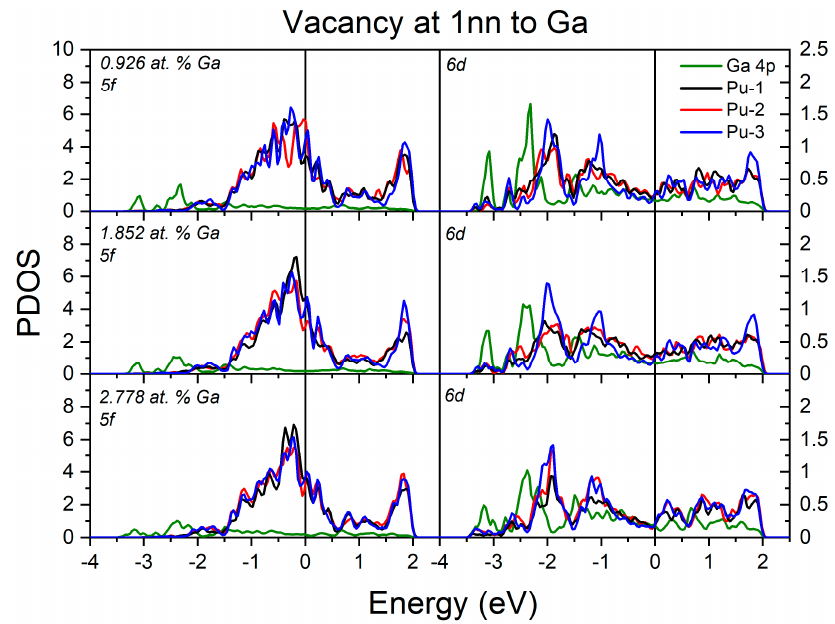
Figure 9. Partial density of states for the 0.926, 1.852, and 2.778 at. % Ga concentrations with a mono-vacancy at the first nearest neighboring distance (1nn) from the Ga. The Pu 5f and 6d states shown for Pu atoms at various distances from the Ga atom (Table 3).